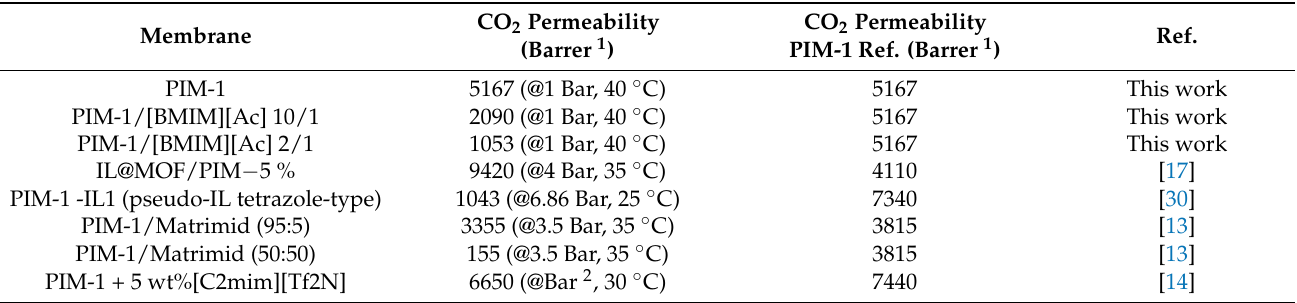
Table 3. Comparison of the experimental data with other literature based on PIM-based gas separation